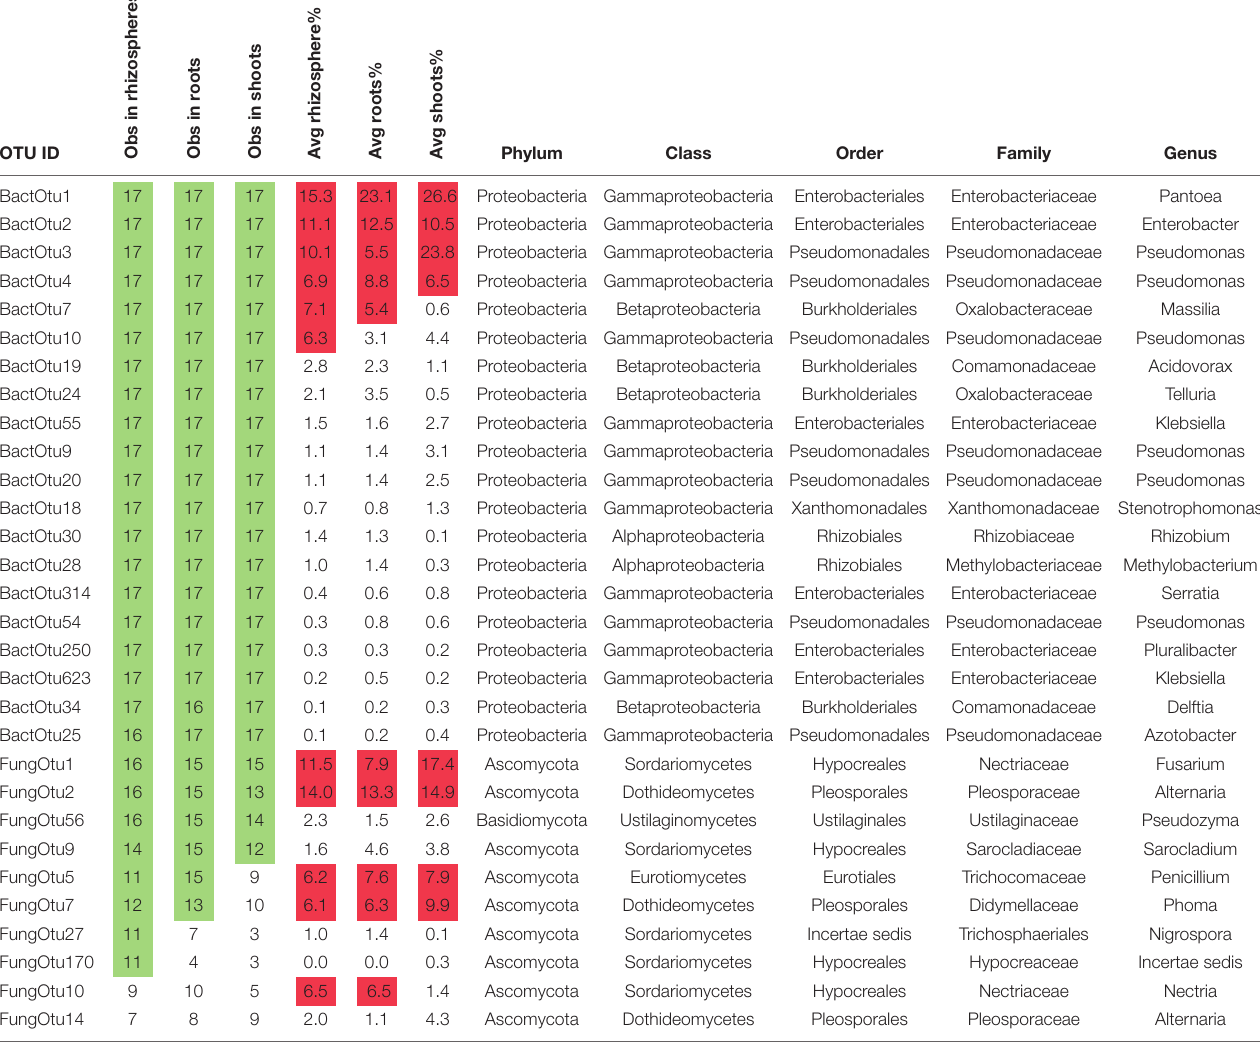
TABLE 1 | Twenty bacterial 16S and 10 fungal ITS with the highest occupancy in plants grown on sterile sand, with “common” observations shaded in green and average read percentages above 5 shaded in